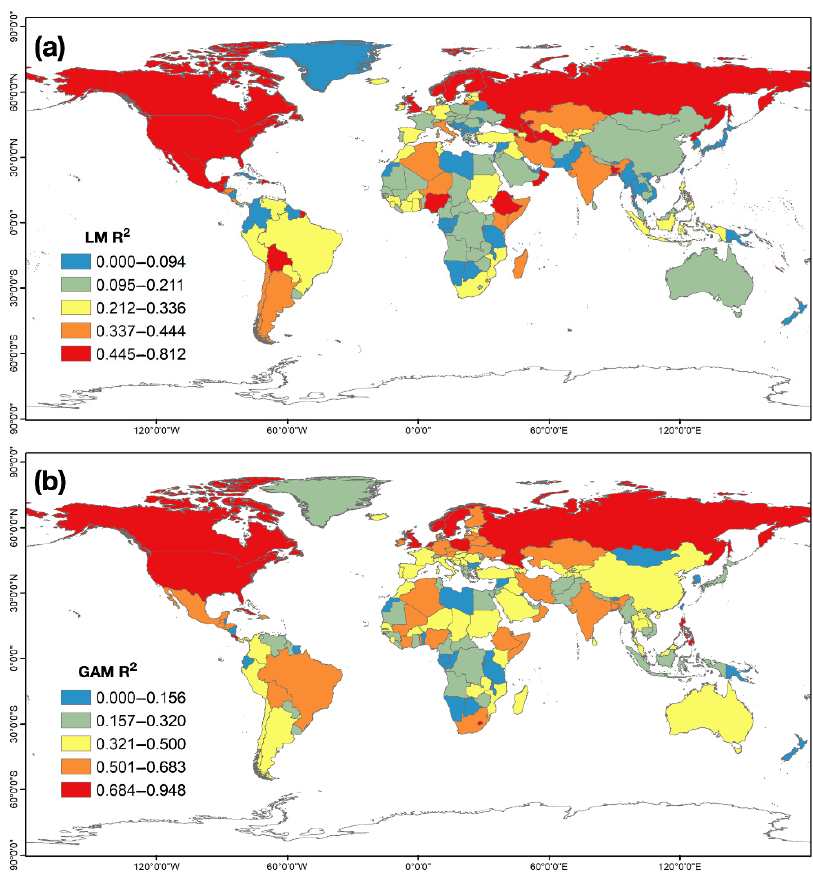
Figure 3. Distributions of R 2 values. ( a ) R 2 values of LM; ( b ) R 2 values of GAM. Based on the GAMs, the effective degrees of freedom (EDF) in each country were